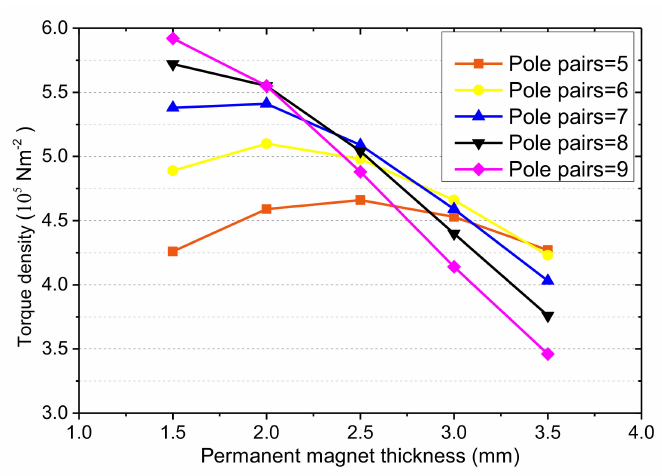
Figure 18. S T versus permanent magnet thickness for several pole pairs.